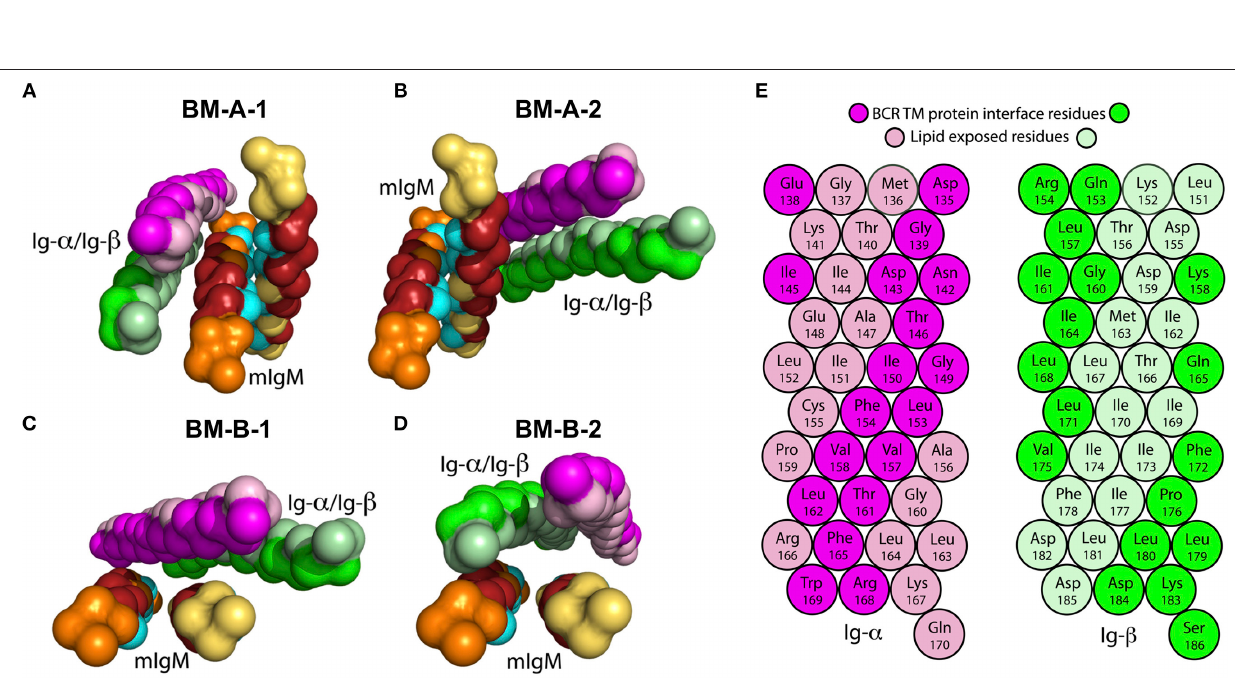
FIGURE 6 | Backbone structure of assembled IgM-BCR TM domains (see Table 2 , Steps 3a and 3b). The conserved sites (TM-C) of mIgM are colored in cyan, while the specific sites (TM-S) are colored in dark red. For clarity, amino acids that belong to neither the TM-C nor to the TM-S are colored orange ( µ -1) and yellow ( µ -2). Ig- α /Ig- β are colored in magenta and green, respectively. Residues facing the IgM interface in the BM-B-1 conformer (C) are shown in bright colors, lipid facing residues in light colors. (A) BM-A-1, (B) BM-A-2, (C) BM-B-1, and (D) BM-B-2 conformations. (E) α -helical scheme of Ig- α and Ig- β TM helices with highlighted interaction sites within the BM-B-1